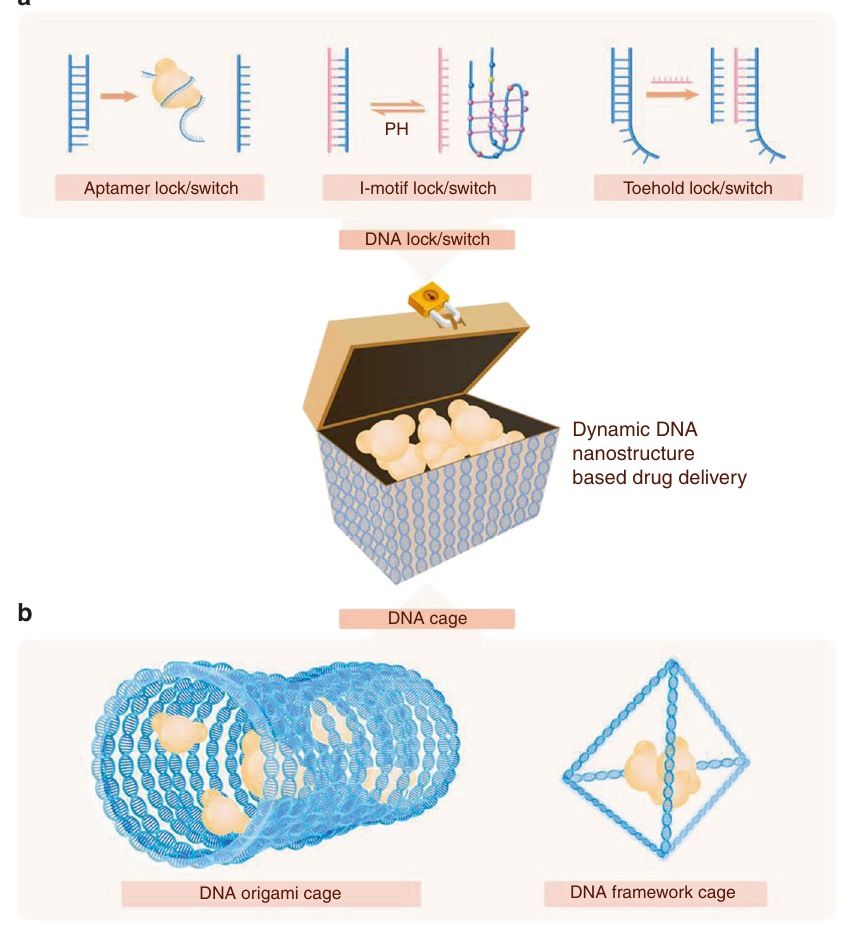
Fig. 6 Drug transport and delivery with dynamic DNA nanostructures. The editability and physiochemical nature of DNA nanostructures allow various drug delivery strategies for dynamic and targeted delivery. a A repertoire of dynamic DNA nanostructures provides a stimulus- responsive lock and switch controlling cargo release. b DNA origami and DNA framework structures enable different cargo encapsulation strategies for cargo